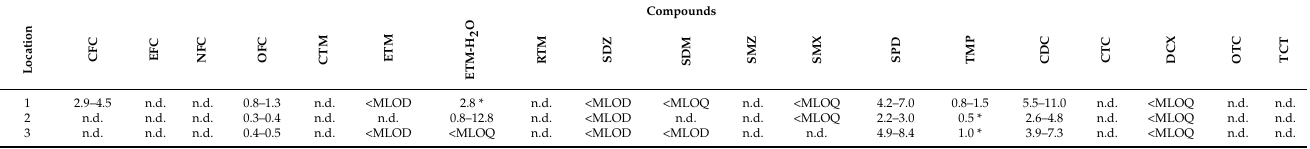
Table 3. The calculated concentration (in µ g/kg) of the three environmental sediment samples. Given as range for duplicates. Ciprofloxacin (CFC), enrofloxacin (EFC), norfloxacin (NFC), ofloxacin (OFC), erythromycin (ETM), erythromycin-H2O (ETM-H2O), roxythromycin (RTM), clarithromycin (CTM), sulfadiazine (SDZ), sulfadimethoxine (SDM), sulfamethazine (SMZ), sulfamethoxazole (SMX), sul- fapyridine (SPD), chlortetracyclin (CTC), oxytetracyclin (OTC), tetracyclin (TCT), doxycyclin (DXC).